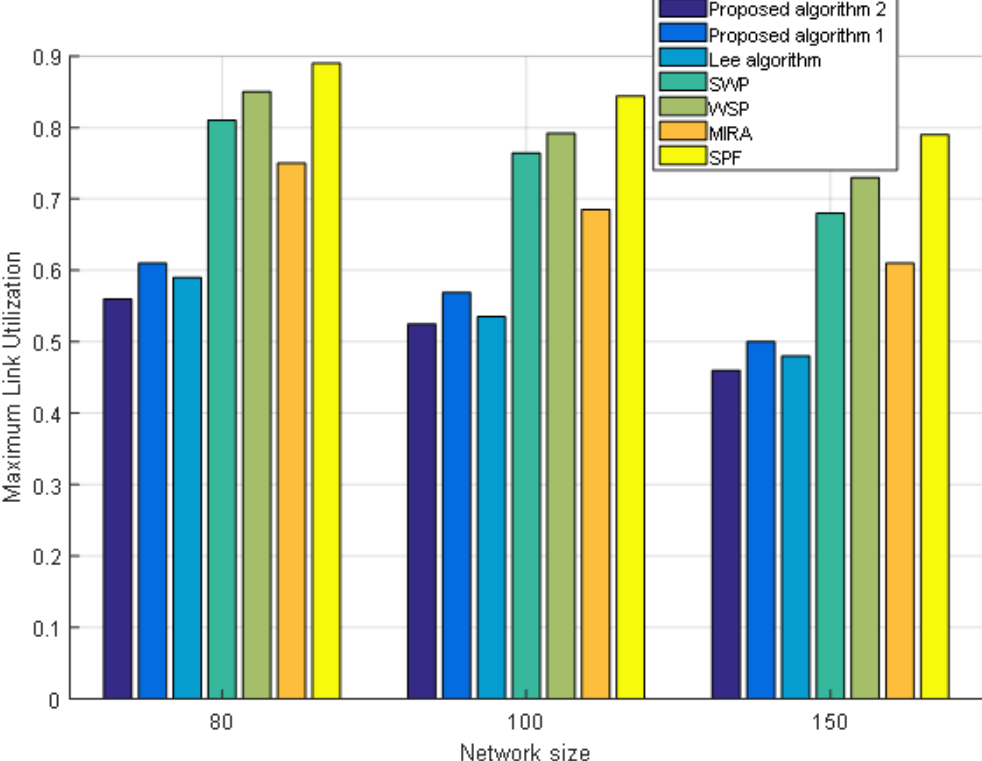
Figure 9. The maximum link utilization under different network